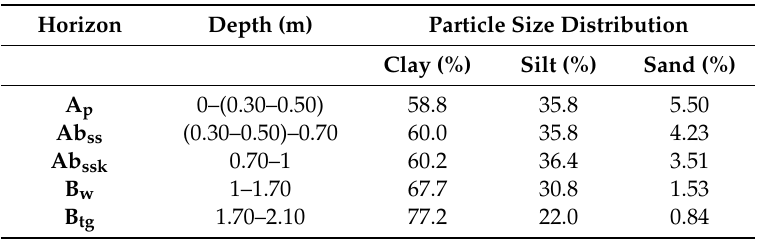
Table 1. Soil properties of the representative profile in the experimental farm.